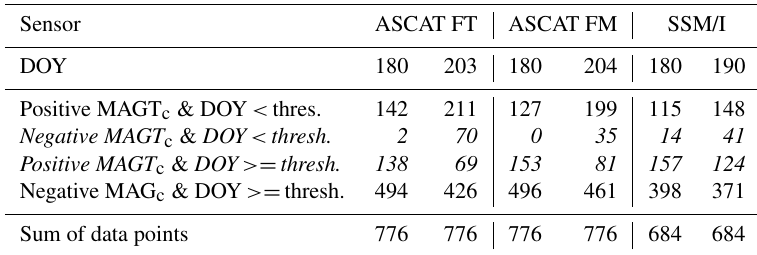
Table 4. Comparison matrix between in situ mean annual ground temperature (MAGT c , at the coldest sensor depth) classes (below or above zero ◦ C) and classified number of frozen days per year from ASCAT (FT – excluding snow melt days; FM – including snow melt days) and SSM/I for 2007–2012. Both the initial 180 days per year (DOY) threshold and the optimal threshold based on the best Kendall’s τ are assessed. Values represent numbers of sites for multiple years. Rows indicating false classifications are in italic. Sensor ASCAT FT ASCAT FM SSM/I DOY 180 203 180 204 180 190 Positive MAGT c & DOY < thres. 142 211 127 199 115 148 Negative MAGT c & DOY < thresh. 2 70 0 35 Positive MAGT c & DOY > = thresh.